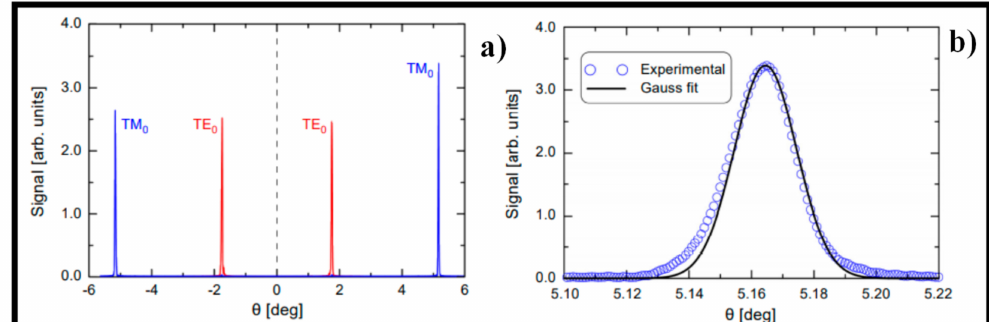
Figure 6. Angle modal spectra of the surface grating coupler used in the experiment ( a ) and a close-up on the in-coupling peak TM0 (full width at half-maximum (FWHM) = 0.024 ◦ ); ( b ) Reprinted from ref. [58].